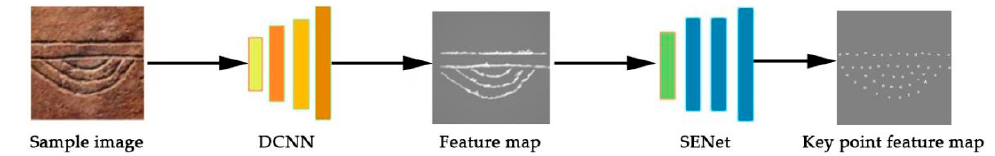
Figure 1. Feature graphic creation with the channel attention module.